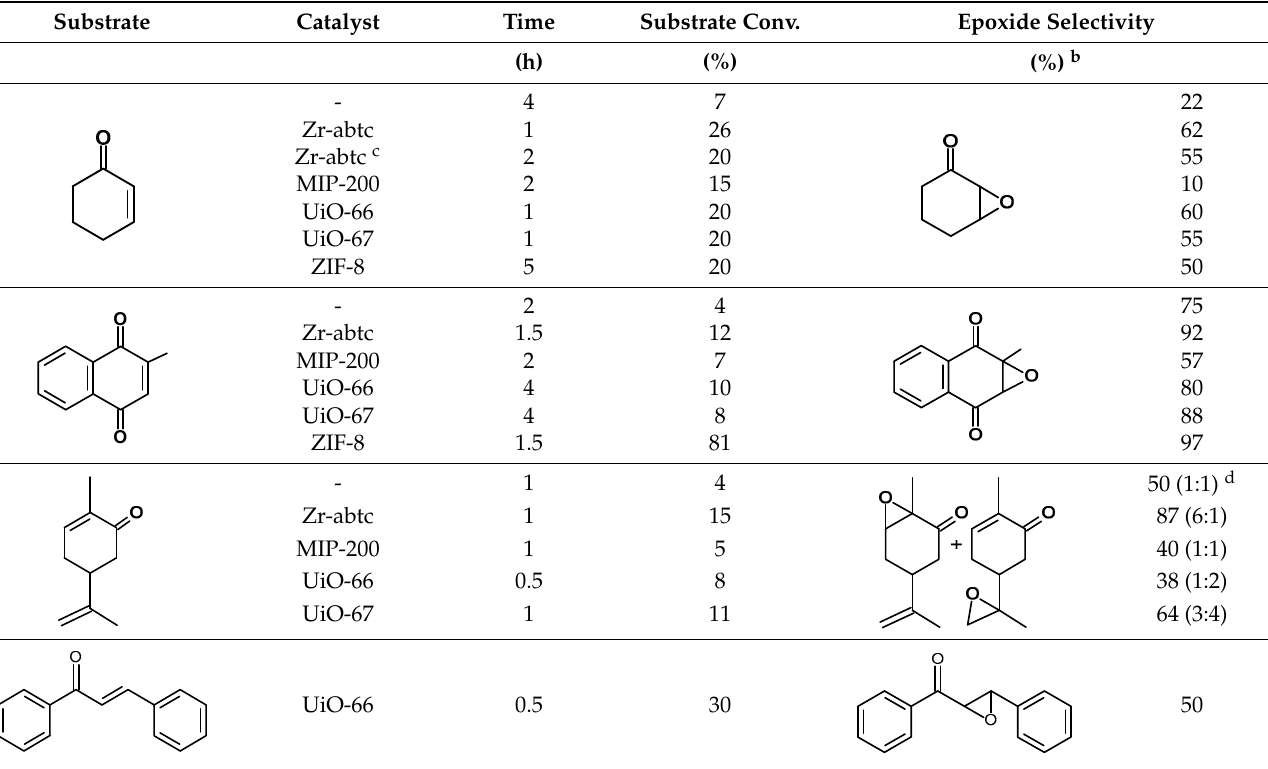
Table 3. Epoxidation of α , β -unsaturated carbonyl compounds over Zr-MOFs and ZIF-8 (adapted from references [91,92,102]). a. Substrate Catalyst Time Substrate conv.